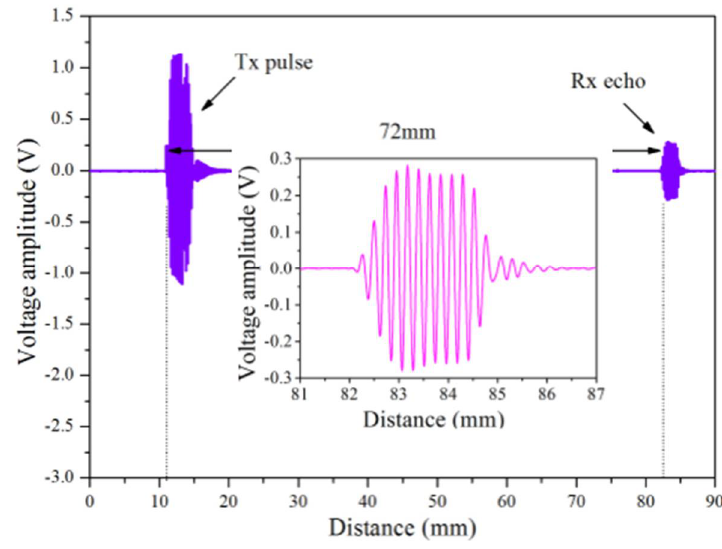
Figure 7. Ultrasound pulse echo signal with a zoomed in view of the echoed signal.